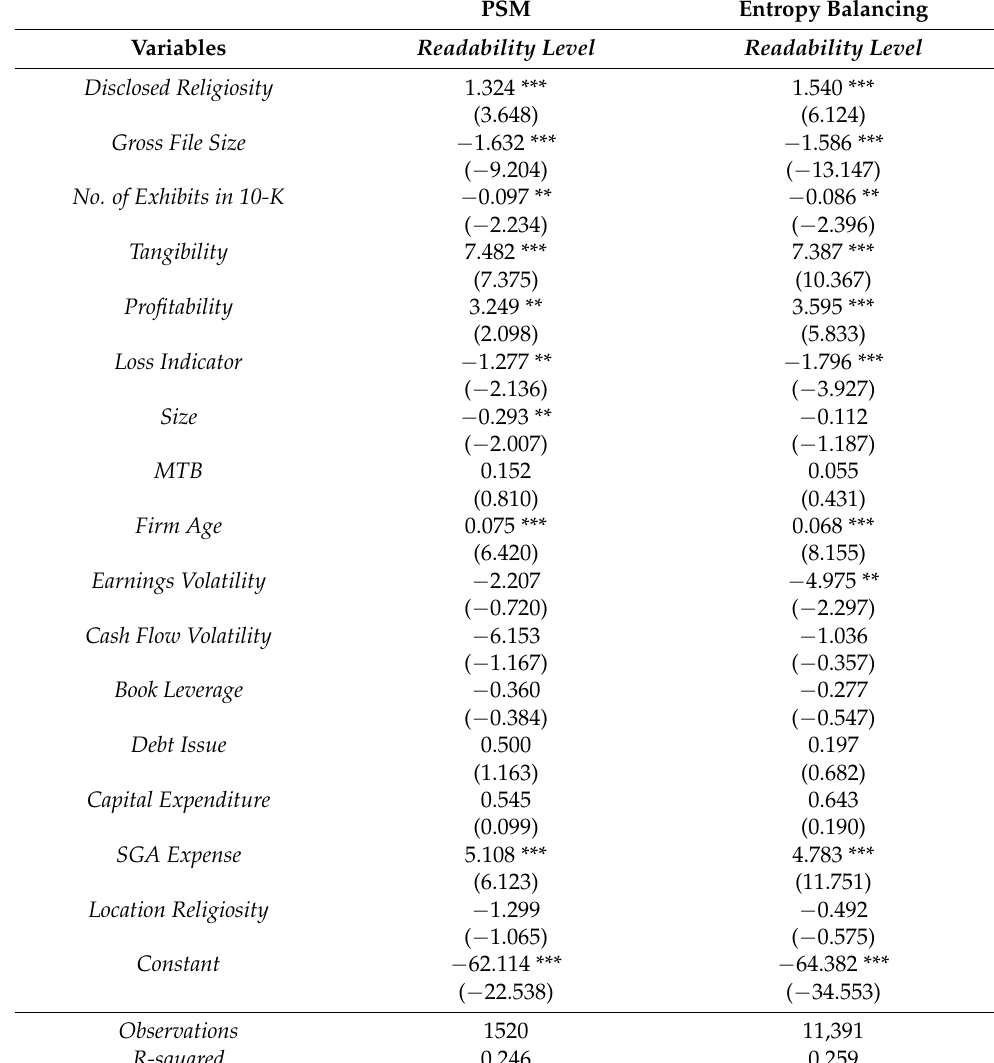
Table 7. Impact of Executive Level Religiosity on Annual Report Readability—PSM & Entropy Approach.